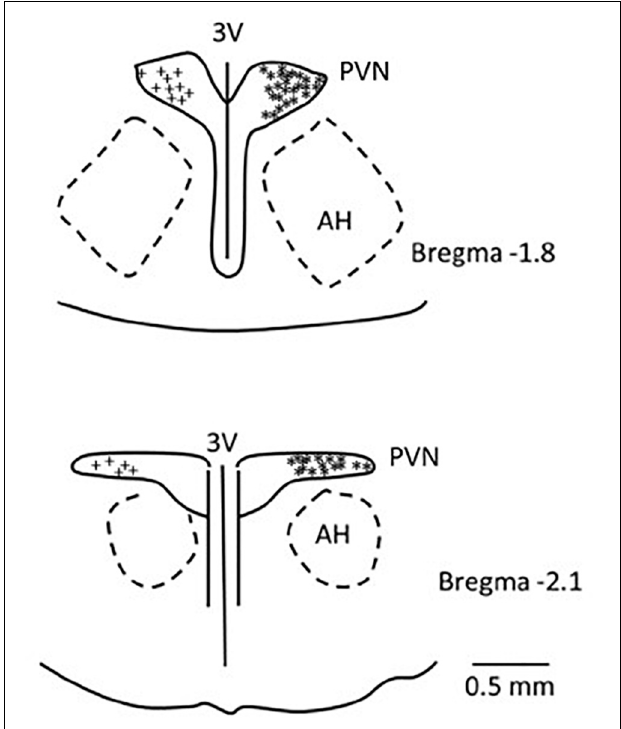
FIGURE 8 | A composite map displays sites of microinjection and recording in the PVN in rats. For ease of presentation, extracellular recording sites in the PVN are displayed on the left (+) and microinjections sites ( ∗ ) on the right. PVN, paraventricular nucleus; AH, anterior hypothalamic nucleus; 3V, third